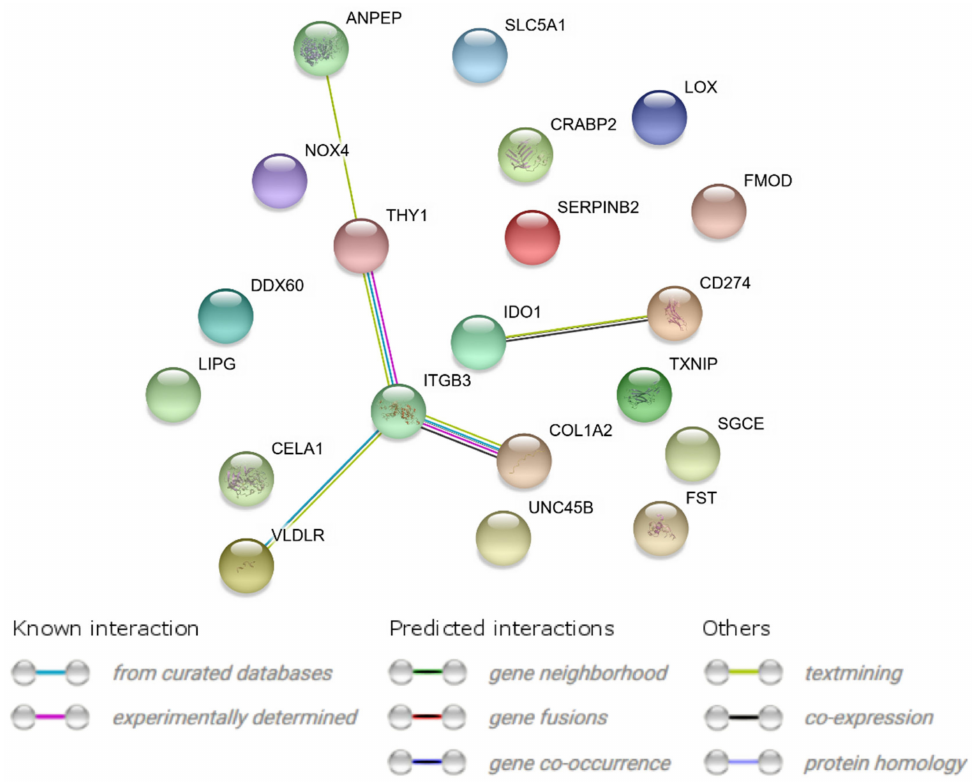
Figure 6. STRING-generated interaction network 10 most upregulated and 10 most downregulated genes that belongs to the “cell differentiation”, “cell growth”, “cell maturation” and “cell develop- ment” GO BP terms as well as “signaling pathways regulating pluripotency of stem cells” KEGG pathway. The intensity of the edges reflects the strength of interaction